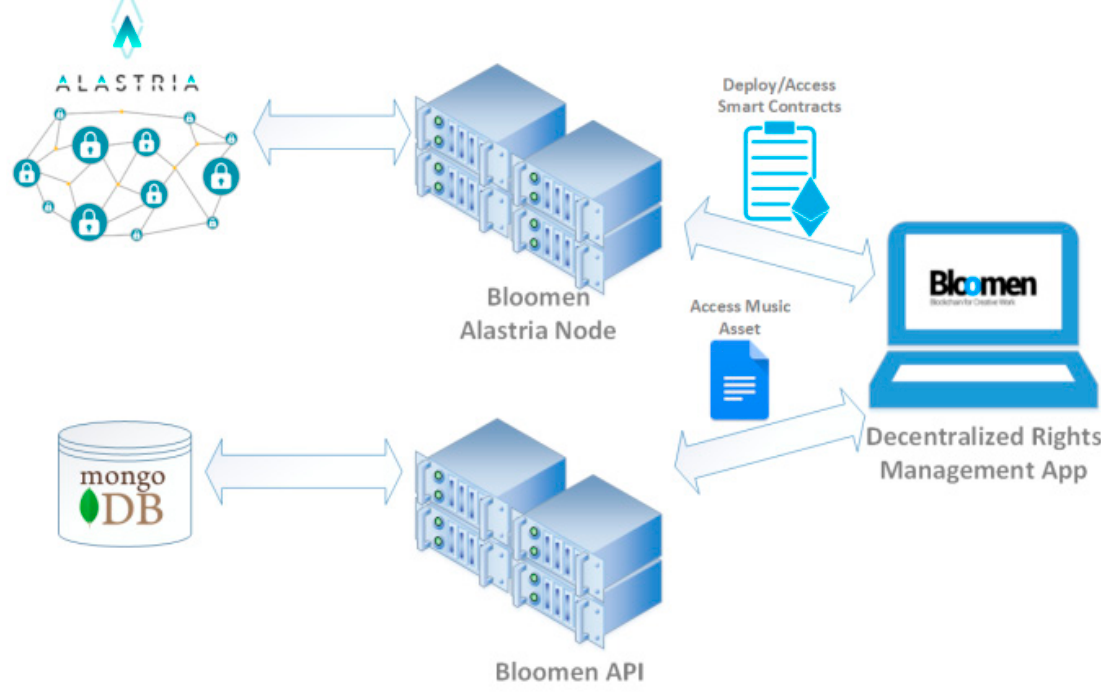
Figure 5. Technical architectural view of all the components.